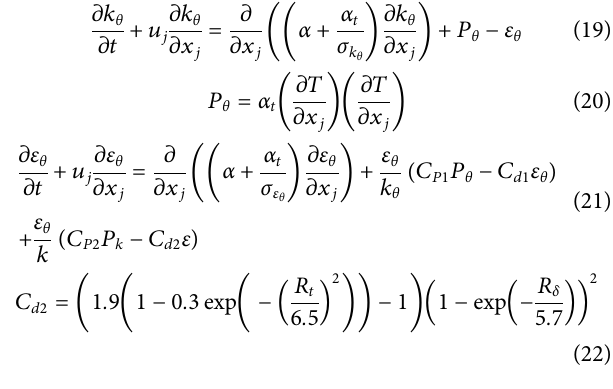
FIGURE 3 | The mesh of computational domain.